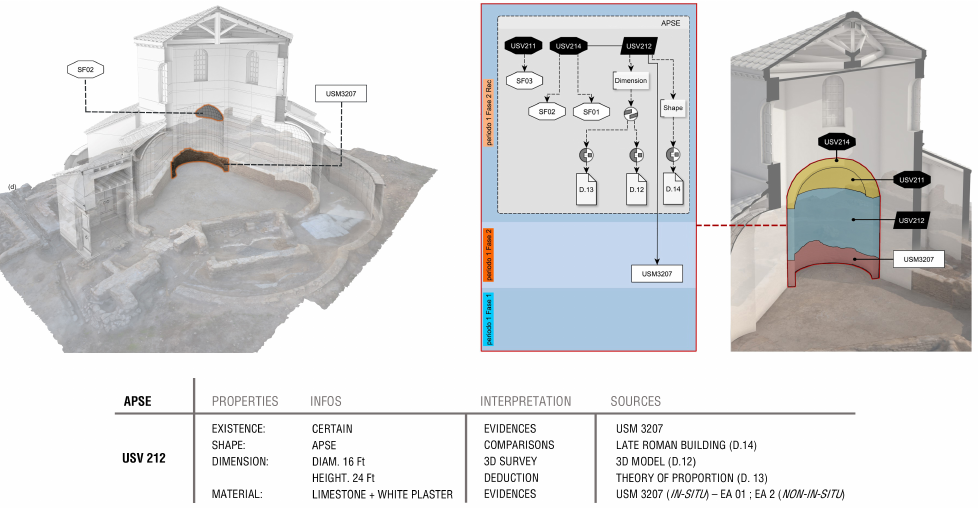
Figure 3. An applied example of the EM: the reconstruction of the apse, USV 212, together with data and paradata used. See colour chart in Table